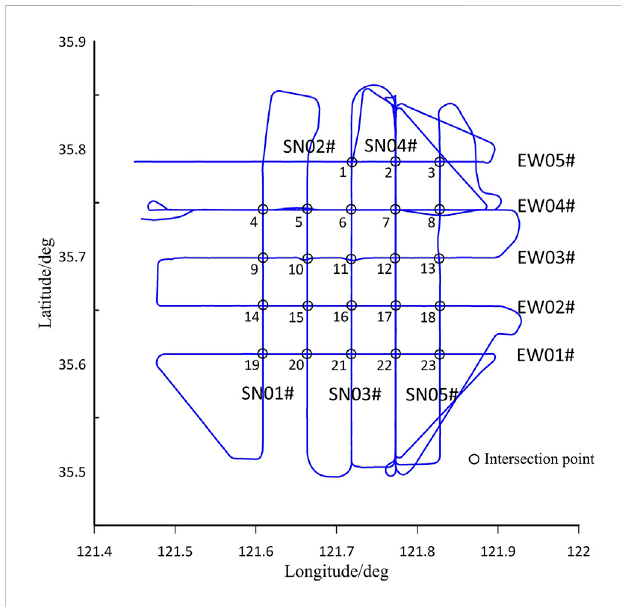
FIGURE 9 Location map of sea trial survey network and intersection points.